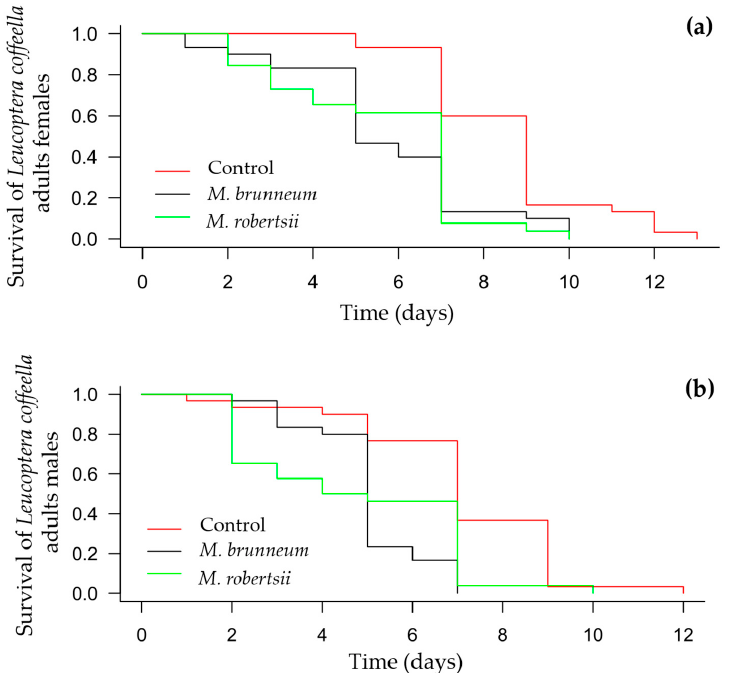
Figure 6. Survival of Leucoptera coffeella adults emerged from coffee seedlings with Metarhizium robertsii and Metarhizium brunneum inoculation by soil drench. ( a ) Survival of L. coffeella females; ( b ) Survival of L. coffeella males. Inoculation of 30 mL of each isolate suspension was to the surface of the soil in each coffee seedling while the control received a sterile solution of Tween 0.05 %.